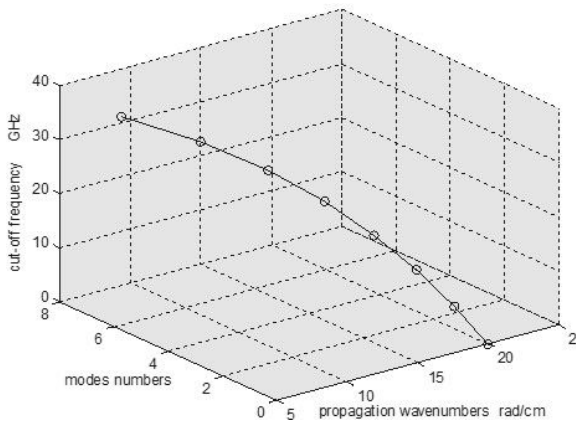
Figure 2: Graphene with higher propagation wave number from the cut-off frequencies of the TE-modes